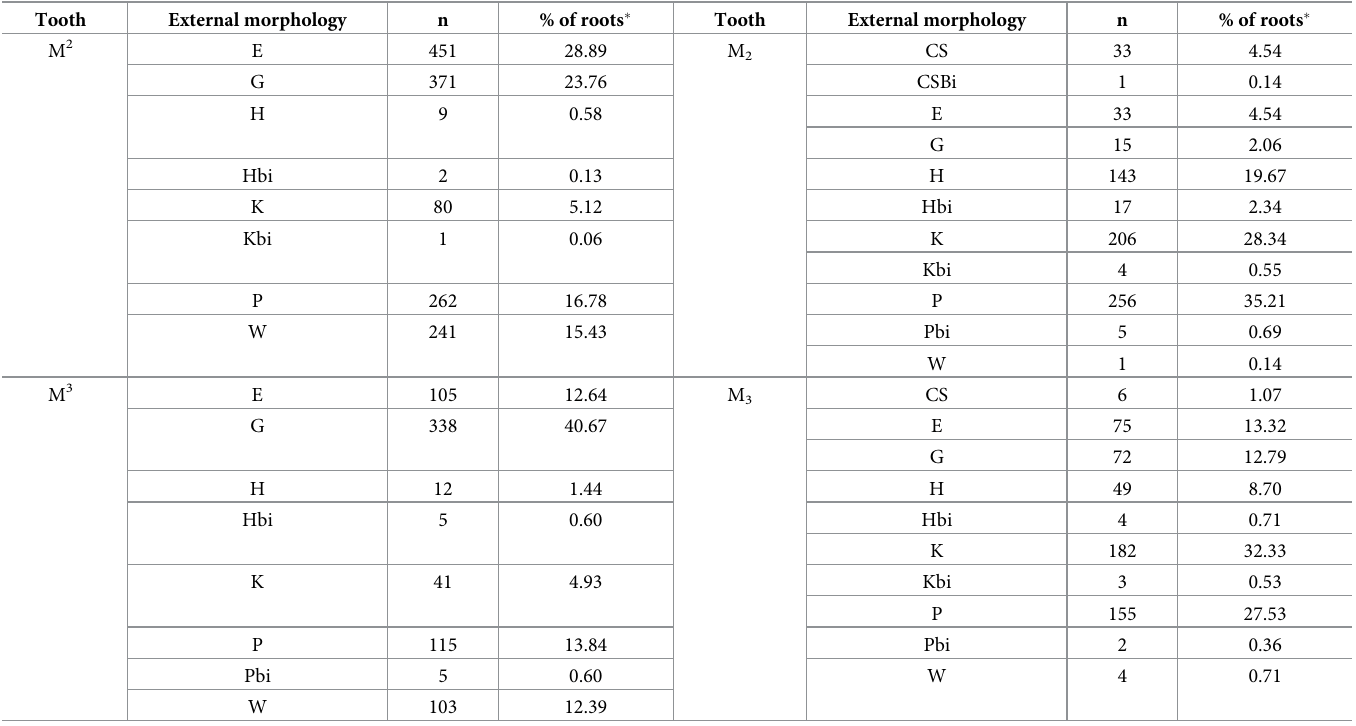
� from Table 3, Bi = bifid. Congenitally absent teeth not included in statistics for this table.